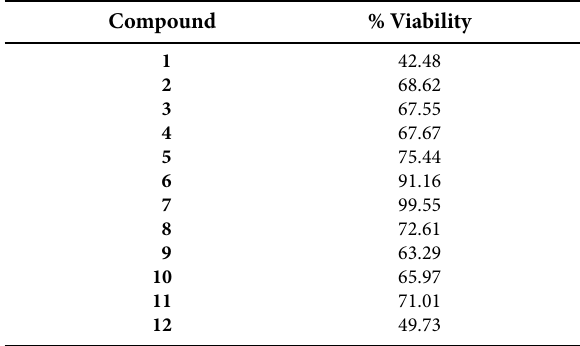
Table 4. % HeLa cell viability obtained for the compounds 1 – 12 .